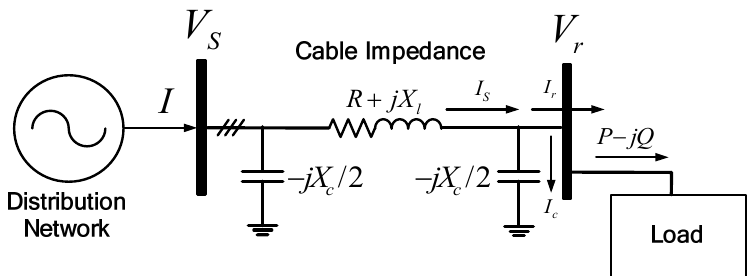
Figure 2. Distribution system submarine cable modeling without distributed generation (DG).